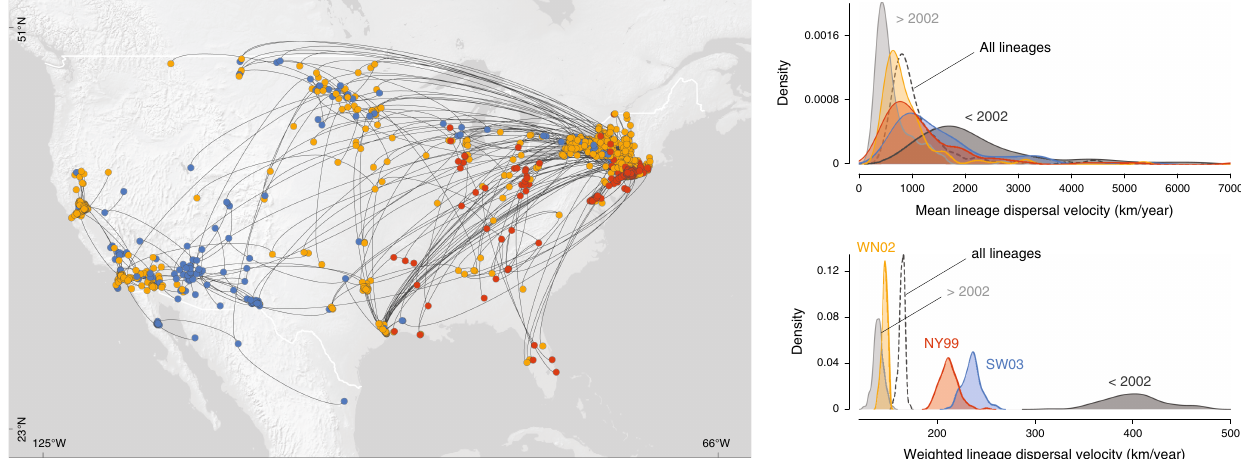
Fig. 3 Comparison of the dispersal history and velocity of WNV lineages belonging to three phenotypically relevant genotypes (NY99, WN02, and SW03). The map displays the maximum clade credibility (MCC) tree obtained by continuous phylogeographic inference with nodes coloured according to three different